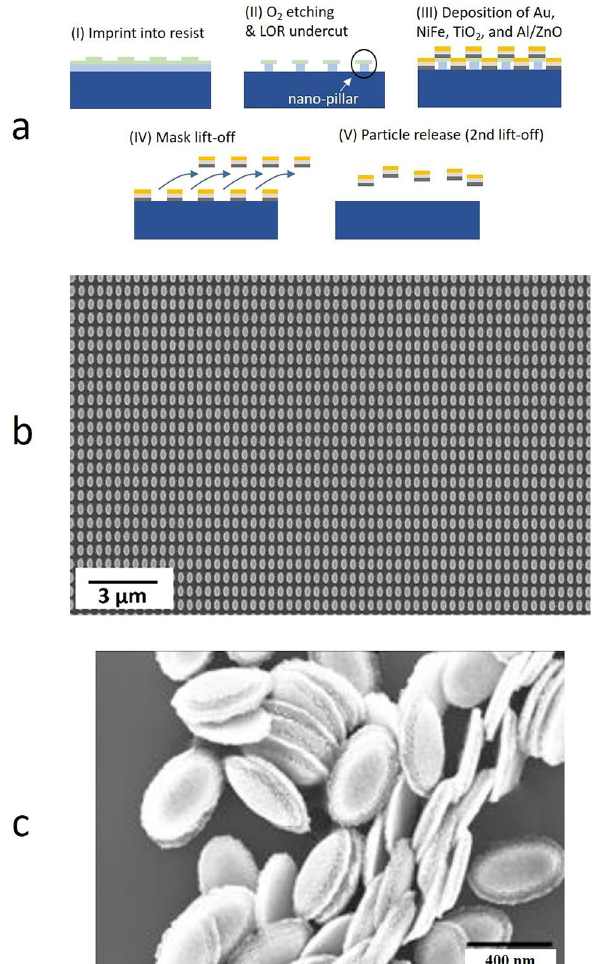
Figure 3. ( a ) Schematic illustration of the NIL fabrication steps. ( b ) SEM image after sputter deposition and mask lift-off (step IV). ( c ) SEM micrograph of released nanoparticles after the lift-off process (step V).